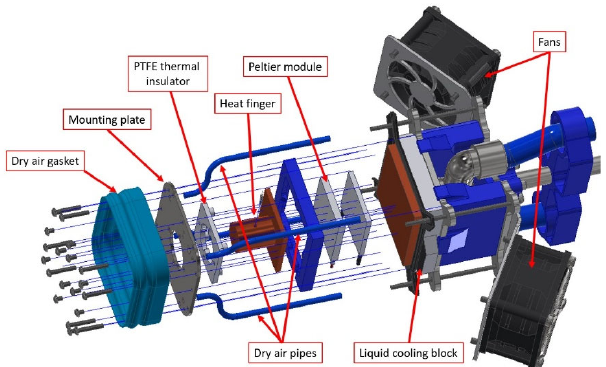
Figure 3. Exploded view of the thermal head containing replaceable “heat finger”.